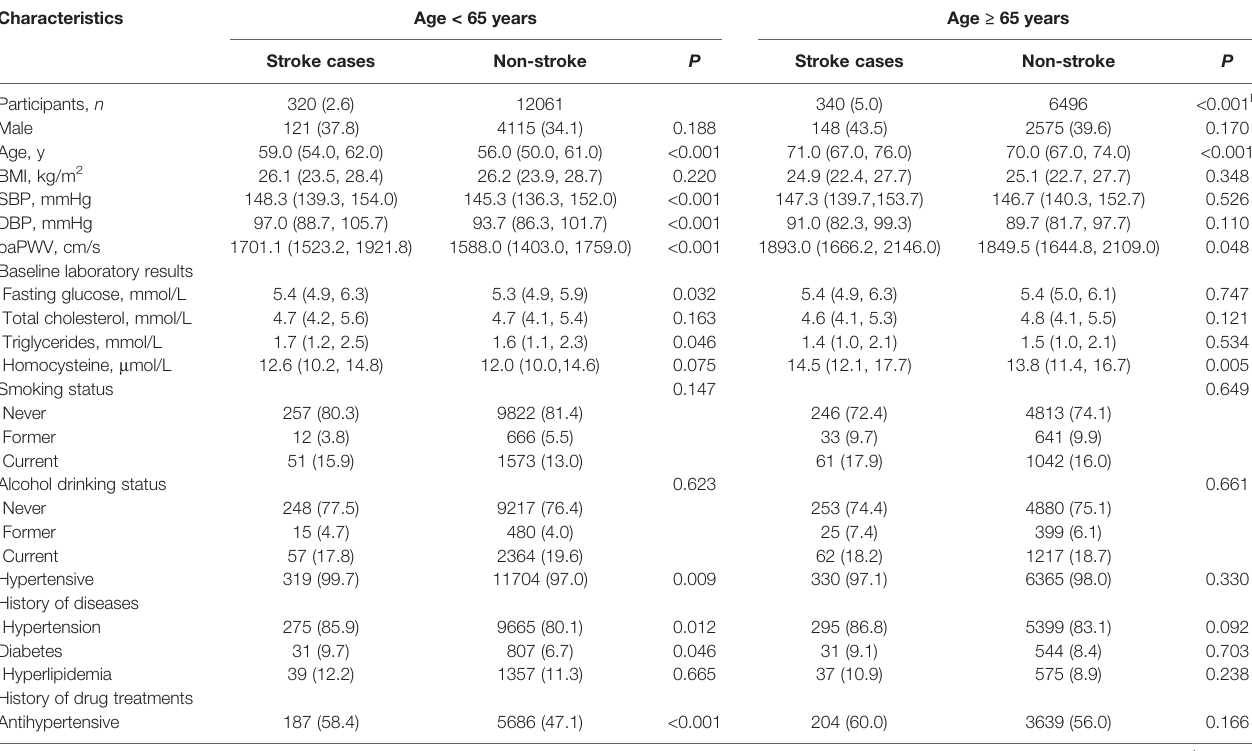
TABLE 1 | Baseline characteristics of study participants strati fi ed by age group A .